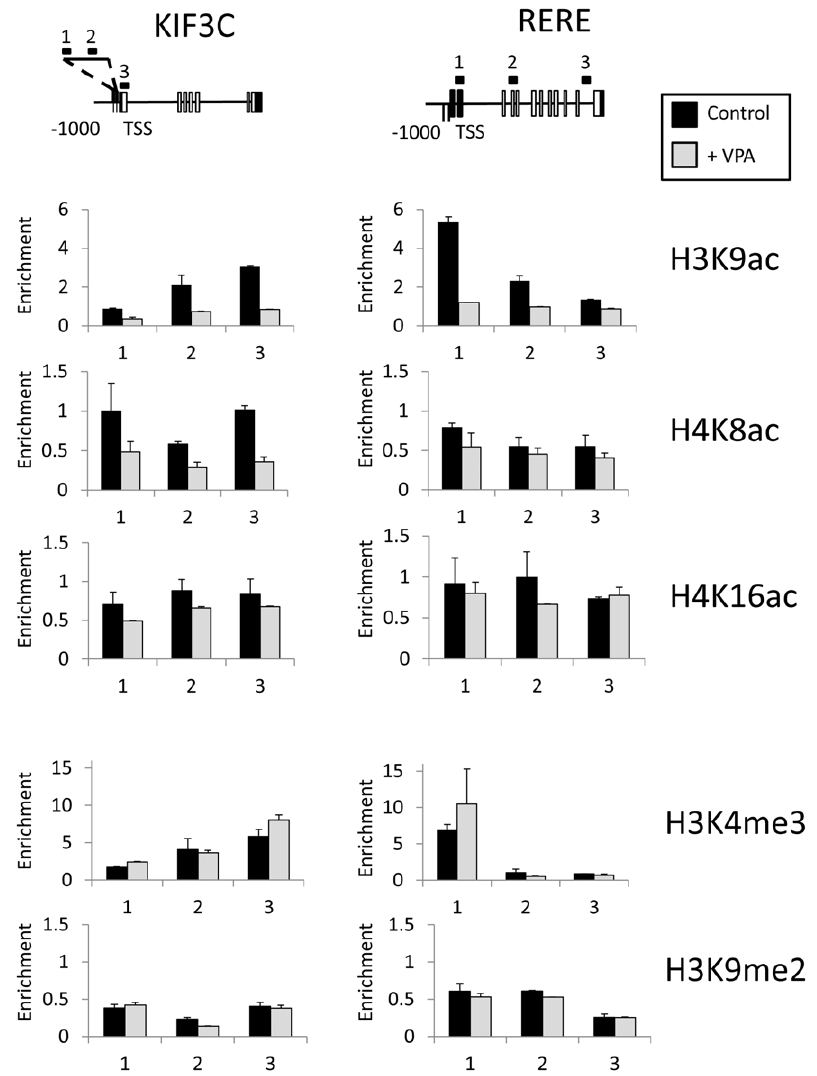
Figure 3. Histone modification distribution on genes up-regulated by VPA. Chromatin immunoprecipitation analysis of histone modifications on two VPA-responsive genes: KIF3C and RERE . Graphs indicate the enrichment of histone modifications at specific primer pairs in untreated cells (Control), and after eight hours of VPA treatment ( + VPA). Histone modification enrichment is shown as a bound:unbound ratio. The primers used are indicated on gene diagrams, which also indicate the transcription start site (TSS), exons (Empty boxes), and untranslated regions (Filled boxes). The abundance of a histone modification (‘ Enrichment ’) is calculated from the ratio of material detected in bound:unbound fractions.